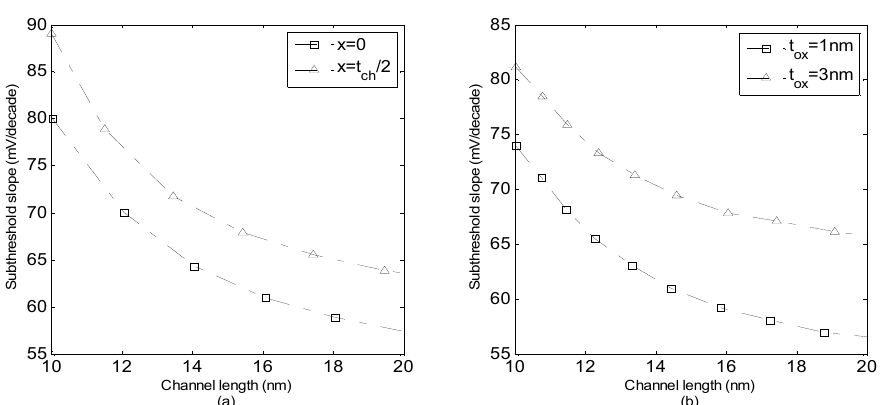
Figure 7. Subthreshold slope versus channel length for ( a ) the front surface and the middle of channel, ( b ) different values of oxide thickness ( V ds = 0.2 V).